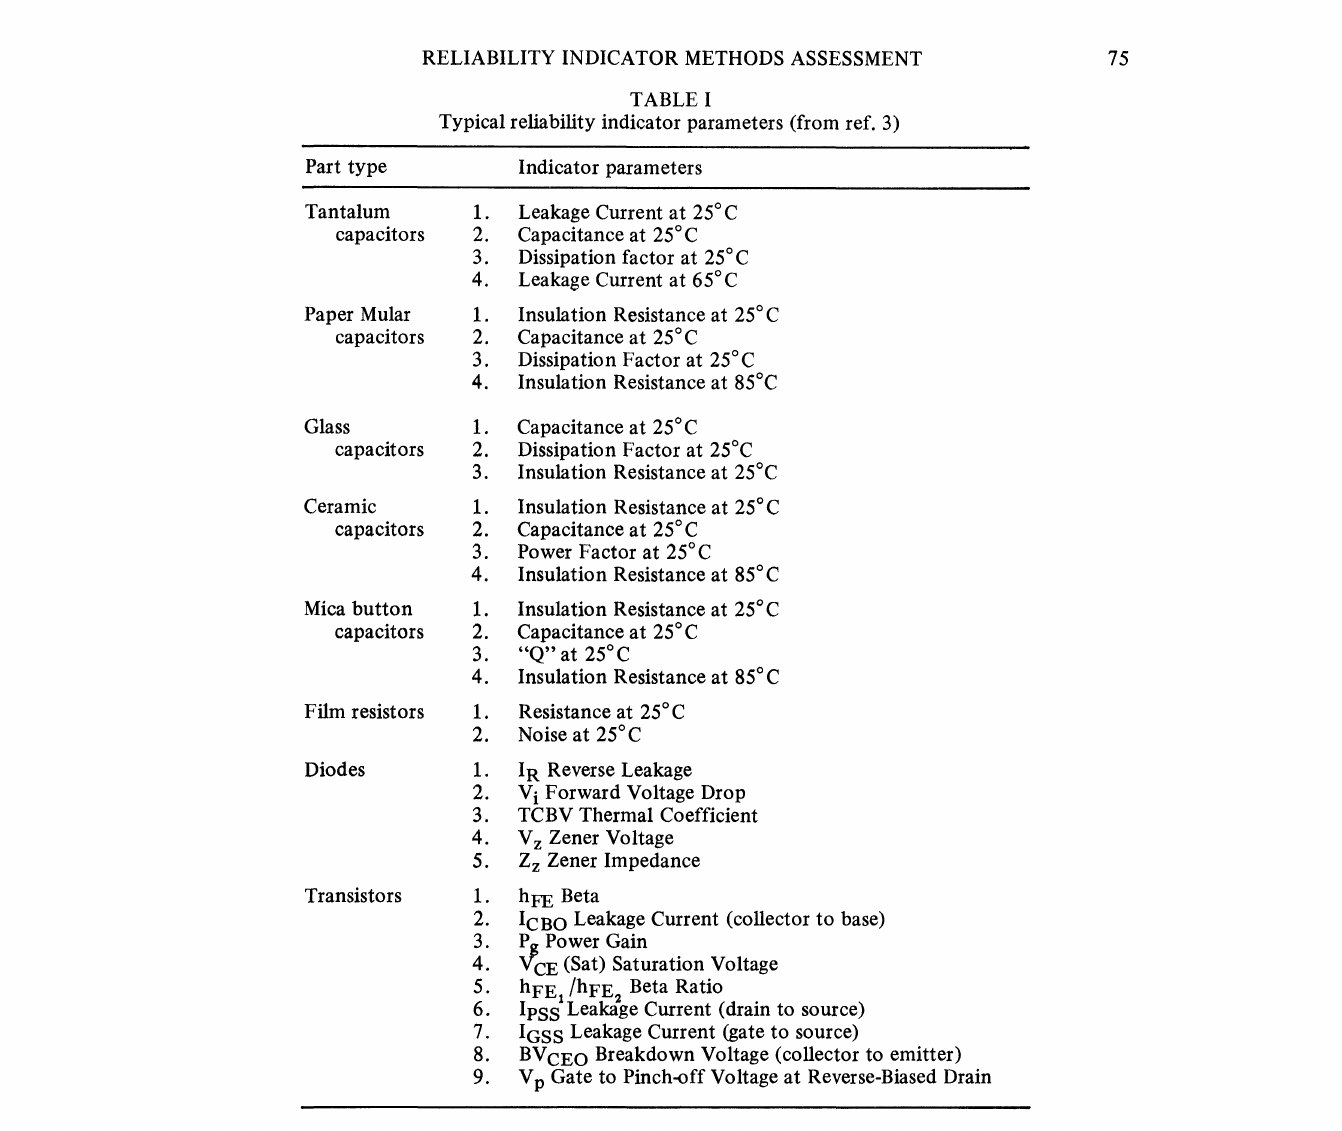
TABLE Typical reliability indicator parameters (from ref.